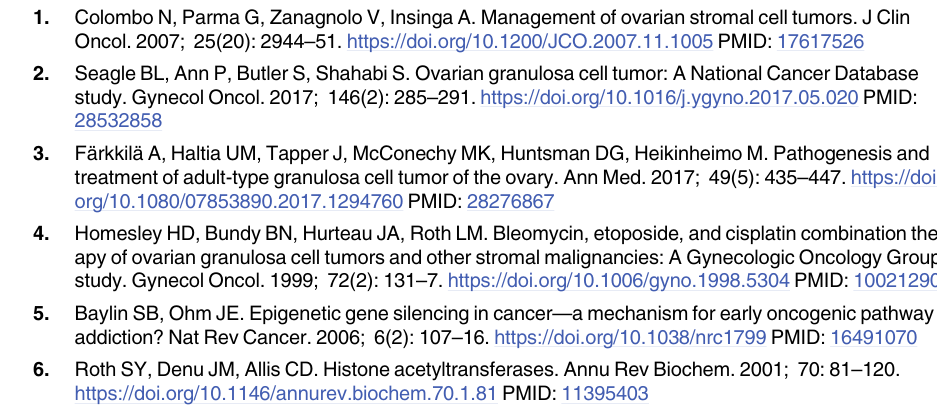
S6 Fig. Expression of E-Cadherin mRNA per an equal amount of total RNA in Fig 3c. Expression of E-cadherin mRNA ( CDH1 ) per an equal amount of total RNA increased after the treatment with 100–200 nM of PS in RT-qPCR. S7 Fig. Expression of E-cadherin mRNA normalized by GAPDH. The expression of E-cad- herin ( CDH1 ) mRNA normalized by GAPDH also increased after the treatment with 100–200 nM of PS in RT-qPCR. S8 Fig. The original images of the immunoblotting analysis in Fig 3c. The same samples were loaded on two gels. The areas shown in Fig 3c were indicated by red frames of the original gels. S9 Fig. The heat map presentation of affected genes included in the gene sets. The heat map presentation of affected genes included in the gene sets is shown as each of the triplicate exper- iments (PS: PS-treated, DMSO: